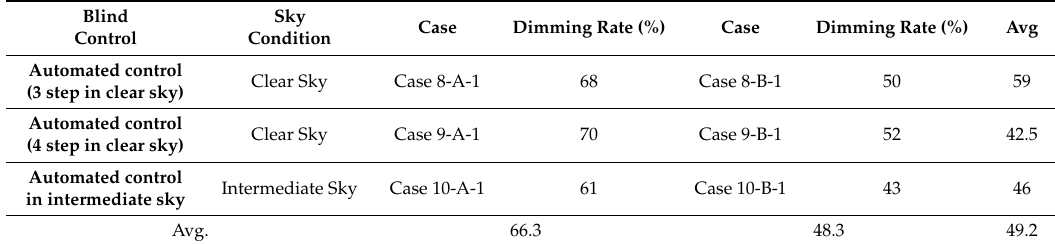
Table 10. Dimming rate for sky conditions under automatic blind